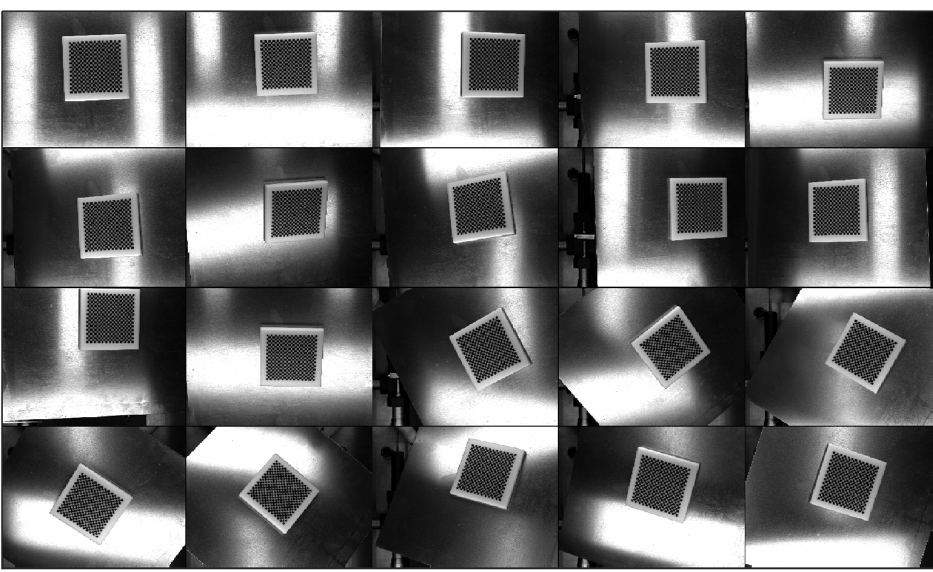
Figure 24. Calibration pattern of camera system.